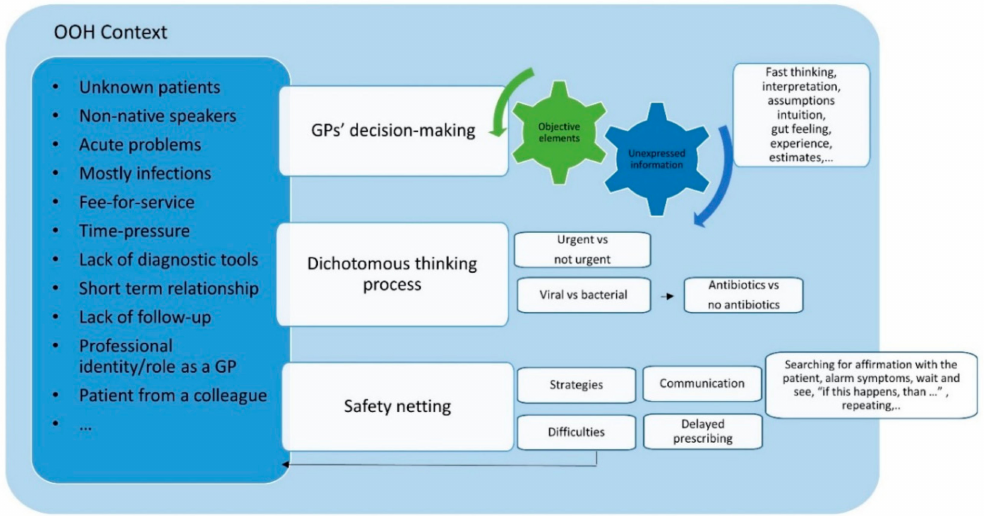
Figure 1. Elements of general practitioners’ (GPs’) antibiotic prescribing decisions during out-of-hours (OOH) primary care consultation on